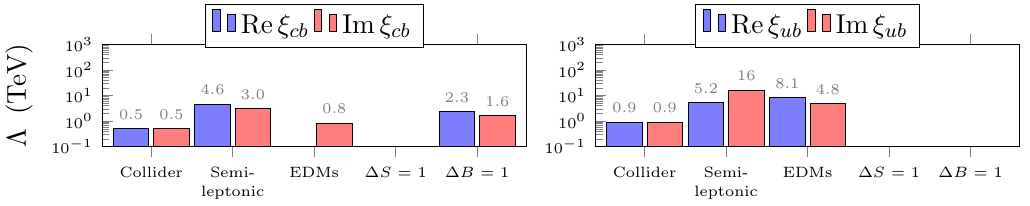
. As noticed in n ud